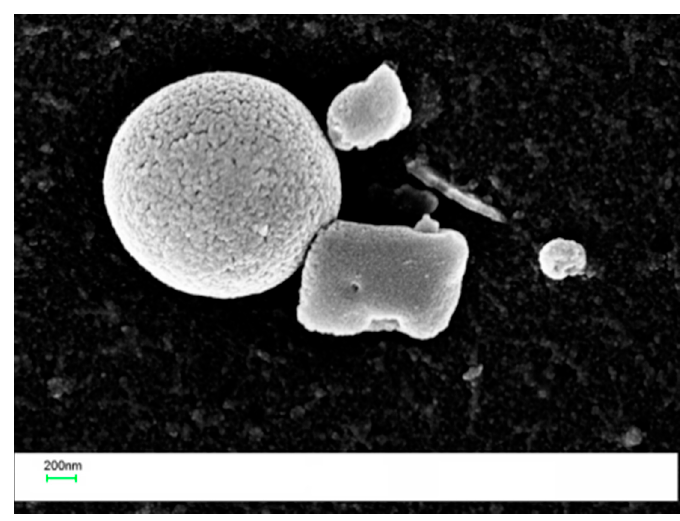
Figure 9. SEM of the interlaminar region for the composites with dissolved in 10 wt % of coPES/1%